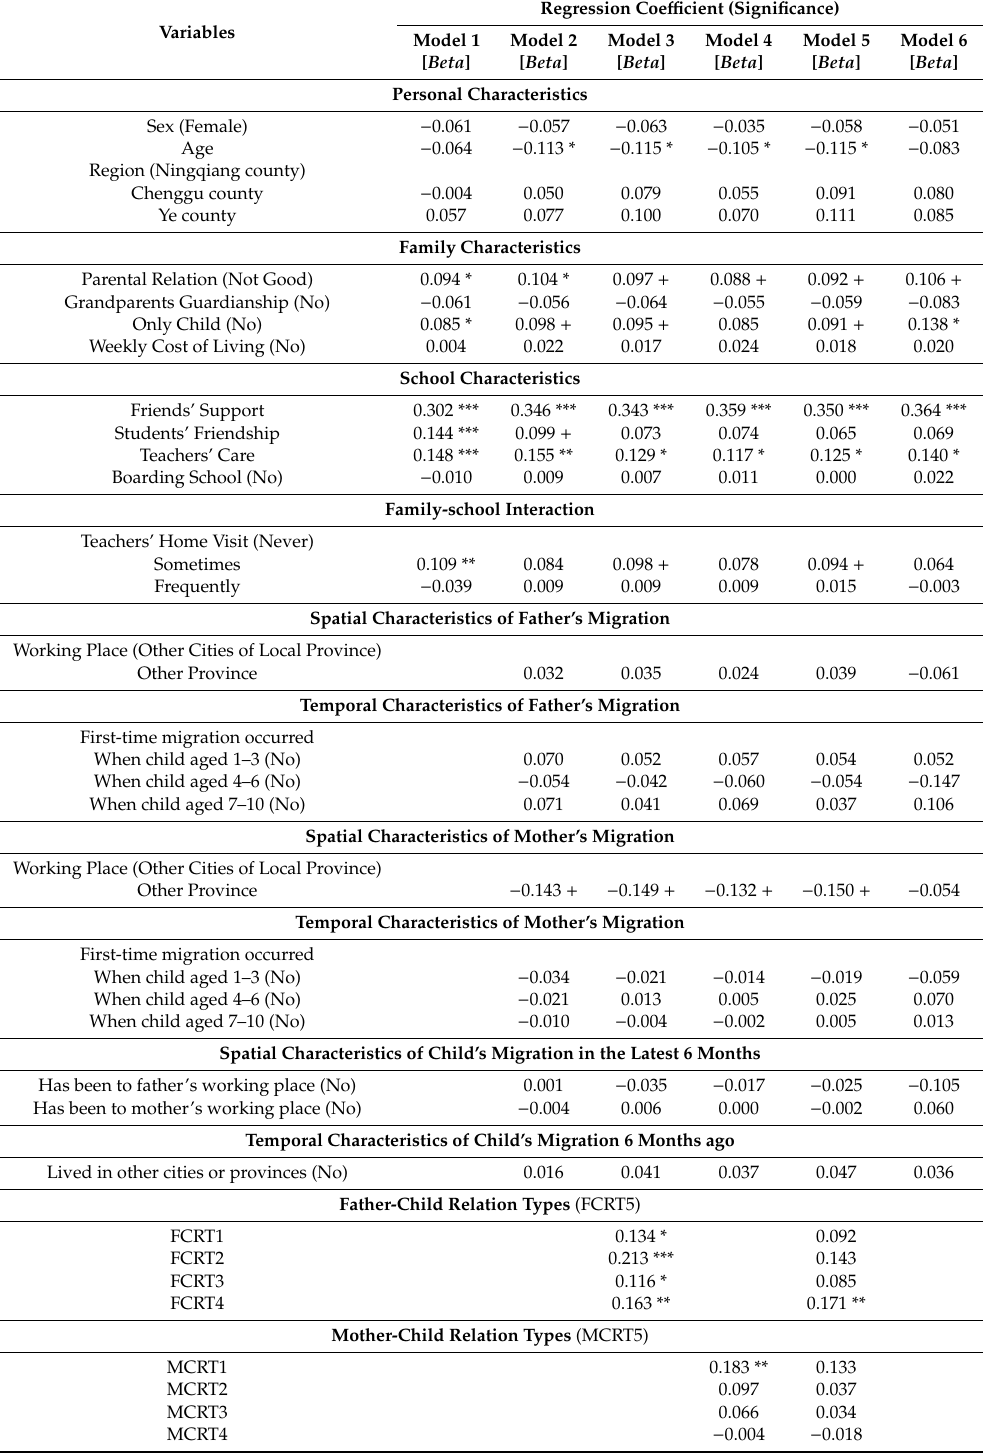
Table 10. Impacts of population migration characteristics and parent-child relation